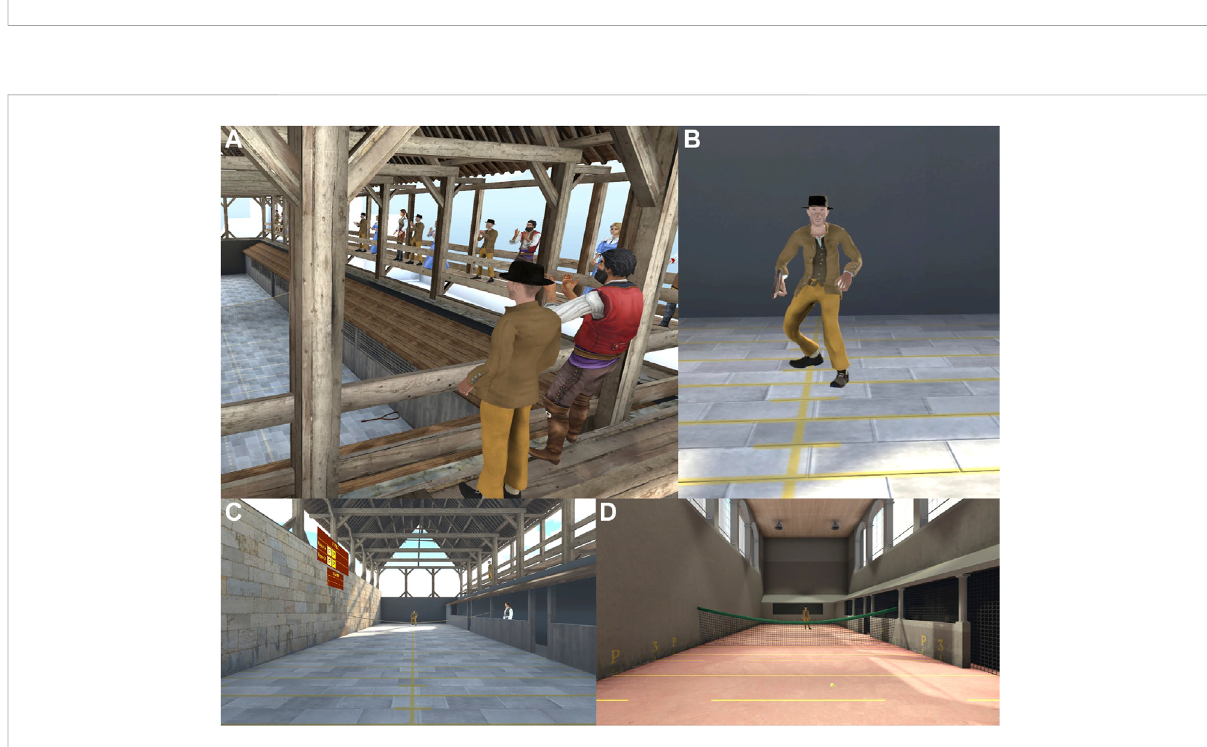
FIGURE 8 Top: The characterspopulating the virtual simulation: thepublic (A) , and the virtual opponent (B) . Bottom: Two versions of courts, 17th century court of Le Pelican, Rennes (C) and actual court of Fontainebleau (D)